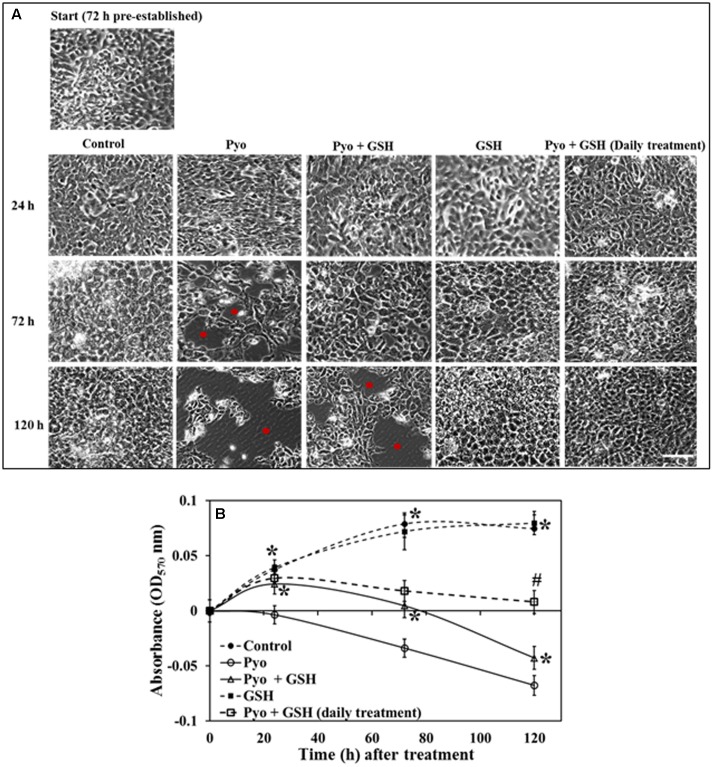
Effect of pyocyanin and GSH on 72 h old pre-established A549 cells. (A) Phase contrast microscopy of 72 h pre-established A549 cells subjected to a one-time treatment with pyocyanin resulted in decrease in A549 adherence levels and confluence especially over both the 3 and 5 days periods, whereas treatment with pyocyanin + GSH resulted in decrease in adherence and confluence over 5 days. Red spots in images indicate empty spaces on well plate surfaces due to non-adherence of cells. Treatment of A549 cells with GSH alone resulted in a confluence level similar to that of the untreated control. Interestingly, pyocyanin + GSH at day 1, followed by daily treatment with GSH for 3 and 5 days resulted in increased recovery of A549 adherence and confluence compared to pyocyanin + one-time GSH treatment. Bar = 50 μm. (B) OD570 nm of A549 cells quantified from microscopy images confirms that pyocyanin resulted in a significant decrease in A549 cell density over 5 days compared to control, GSH and pyocyanin + GSH at all three time points. Daily GSH treatment resulted in a significant increase in OD in comparison to a pyocyanin + single GSH treatment. (B)
∗P < 0.05 compared to pyocyanin treatment and #P < 0.05 compared to pyocyanin + single GSH treatment. Data represent mean ± SD; n = 3 independent experiments.